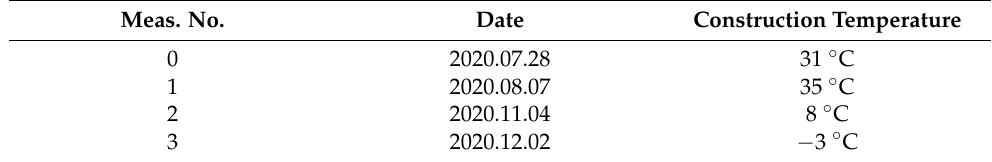
Table 1. Geodetic measurements conditions. Meas.